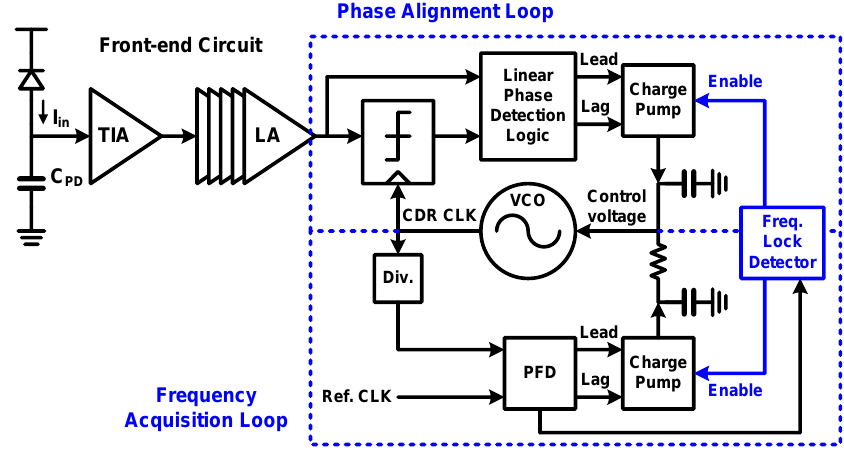
Figure 43. Sequential locking CDR presented in [29].